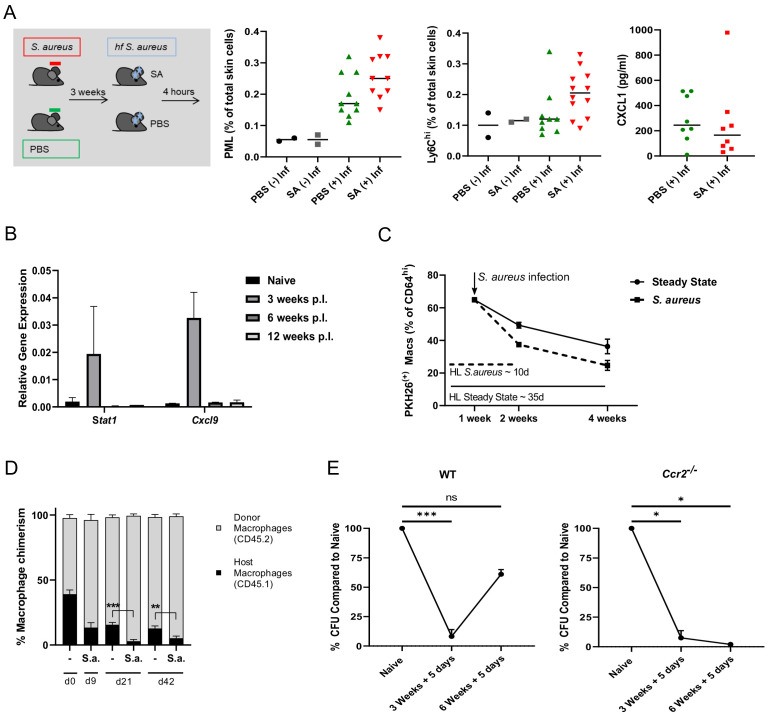
Innate memory is a transient effect and independent of skin microbiota.(A) C57BL/6J mice harbouring the sDMDMm2 microbiota were colonized with S. aureus under axenic conditions, inoculated 3 weeks later with fixed bacteria (108 CFU in 10 µl PBS) or PBS and analyzed for skin infiltrating PML, Ly6Chi monocytes and skin CXCL1 levels after 4 hr (n: 10–12 biological replicates representing two independent experiments). (B) RNA expression of sorted CD64hi dermal Mφ from S. aureus infected mice or naïve mice analyzed 3, 6 and 12 weeks after infection (n:2–4 biological replicates from two independent experiments). (C) Wt mice were treated i.v. with PKH26 red fluorescent cell linker. One week after labeling, mice were infected i.d. with S. aureus. After another 1 and 3 weeks, the contribution of PHK26 positive to all CD64hi dermal Mφ was quantified (n: two biological replicates per time point from two independent experiments). (D) B6-CD45.1 mice were transplanted with 107 bone marrow cells from B6-CD45.2 congenic mice after fractional lethal irradiation. 8 weeks after transplantation dermal Mφ chimerism was determined by flow cytometry analysis using CD45.1 and CD45.2 antibodies (d0) or infected with S. aureus (107 CFU in 10 µl PBS) intradermally in the left ear. At the indicated time points the mice were sacrificed and dermal Mφ chimerism was determined by flow cytometry in the infected (S.a.) and uninfected ears (-). (n: three biological replicates for d0, and four biological replicates for all other groups). (E) Wt and Ccr2-/- mice were i.d. infected with S. aureus (107 CFU in 10 µl PBSl) and i.d. (re-)infected 3 or 6 weeks later with the same amount of bacteria and analyzed for bacterial load after an additional 5 days (n: three biological replicates from one independent experiment for the 6 week time points). Data were analyzed using two tailed unpaired T test. Error bars are mean ± SEM. *p<0.05, **p<0.01, ***p<0.001.